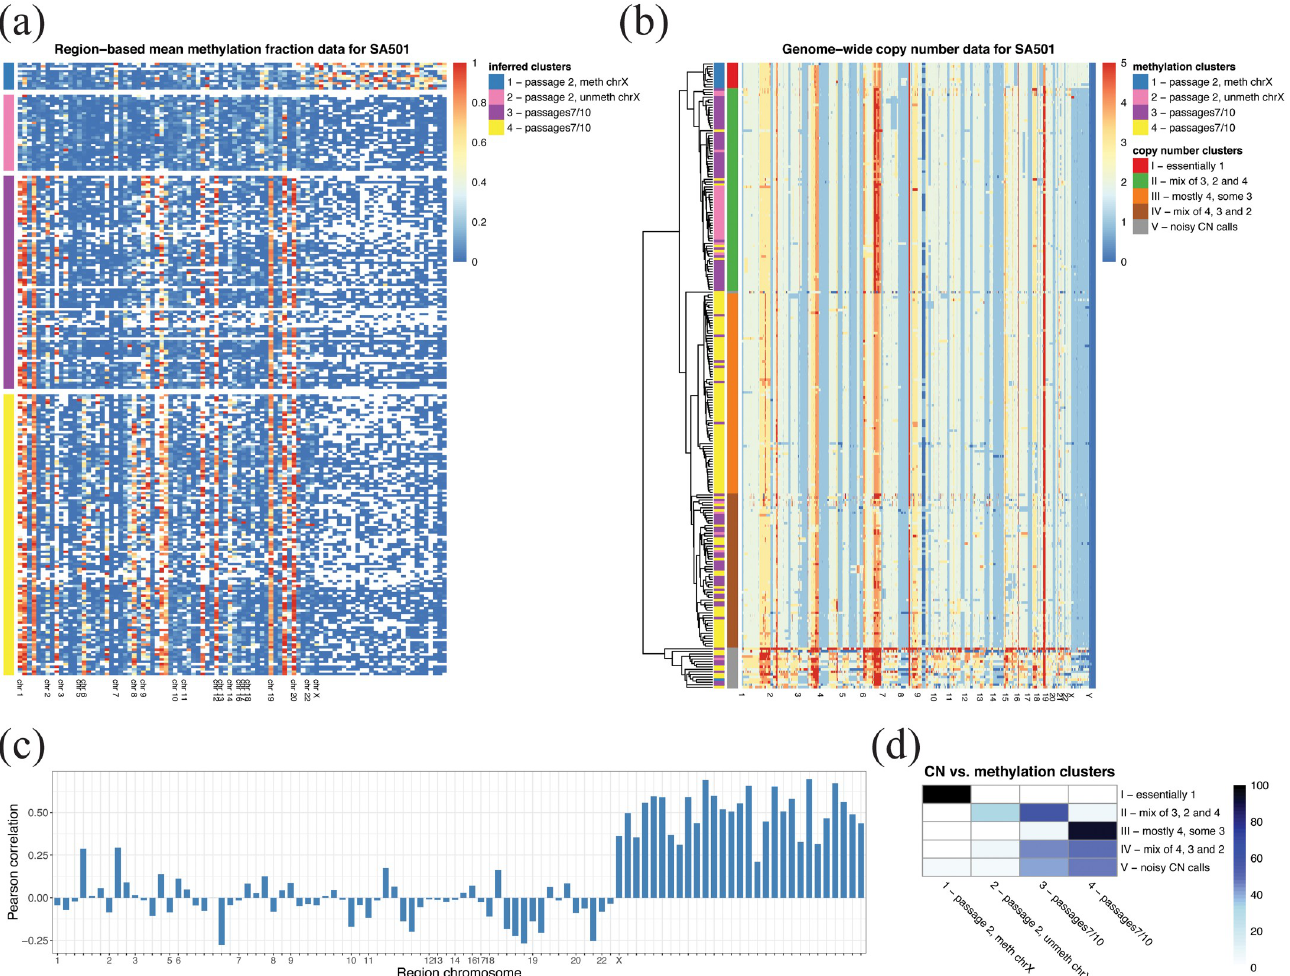
Fig 8. Results for patient SA501. (a) Mean methylation level for each of the 94 NMF-selected regions (CGIs) for patient SA501 across all cells ordered according to the four methylation clusters found using EpiclomalRegion. Rows are cells, and columns are CGIs. (b) Inferred genome-wide copy numbers for the same cells as in (a) clustered using a ward.D2 hierarchical clustering method and Euclidean copy number distances. Note that copy number 5 means five or more copies. To call copy number changes, we used the methylation sc-WGBS data. Only one epiclone and one copy number clone matched, the remaining clones transcended each other. (c) Pearson correlation between mean methylation data and copy number data in each of the 94 regions. There was correlation in chromosome X, but not in the autosomal chromosomes. (d) Heatmap showing the percentage of cells in the copy number clusters (rows) that are in the methylation clusters (columns); rows sum up to